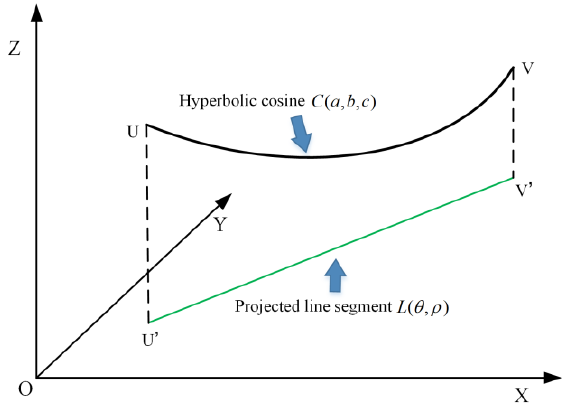
Figure 4. 3D perspective view of the power line model geometry.